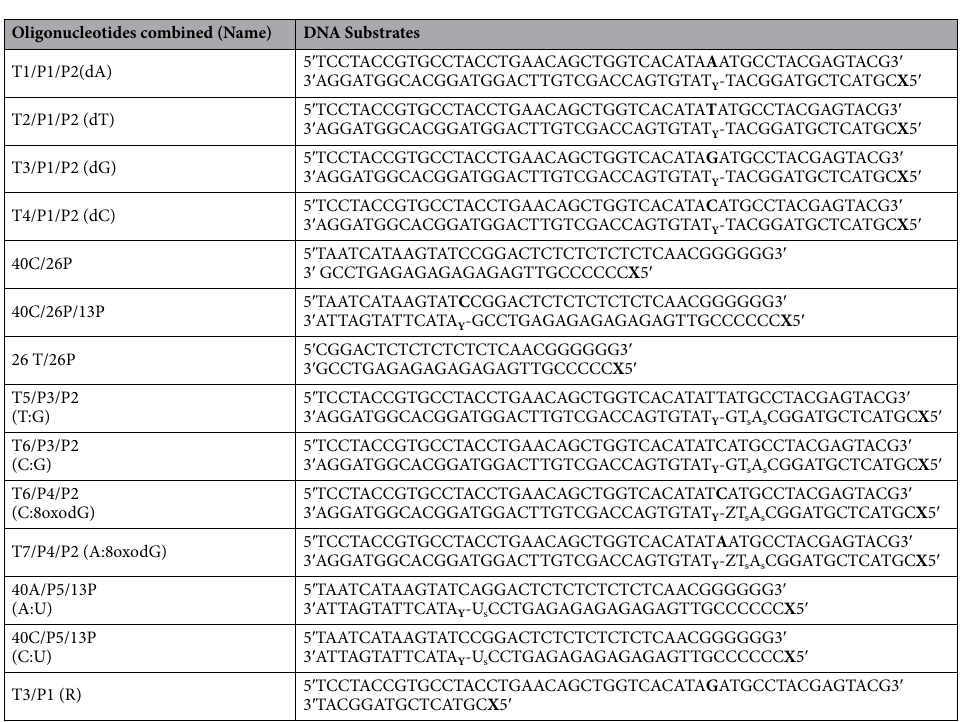
Table 3. The DNA substrates prepared for different biochemical assays performed in this study by annealing the oligonucleotides listed in Table 2. The names of the DNA substrates prepared are mentioned in the brackets in column 1. The gap in the 1 nucleotide gapped DNA substrates is shown by a hyphen.